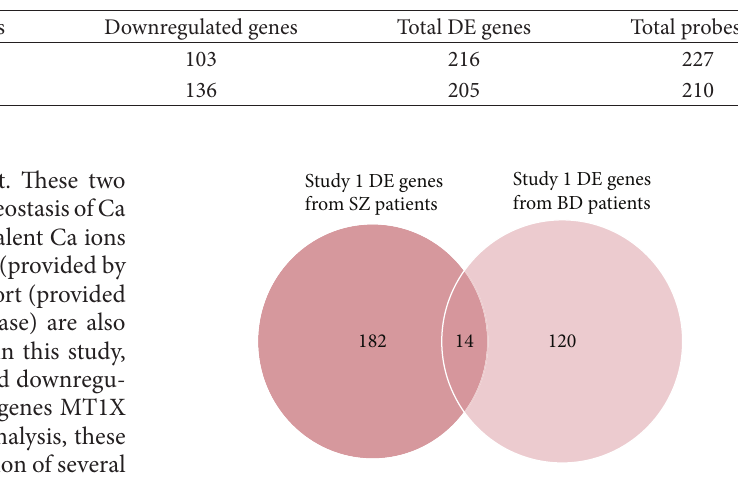
F 2: Venn diagram drawn based on DE genes in SZ and BD patients compared with controls of the �rst study from Brodmann�s Area 10 (cognitive functions, goal formation functions). e com- mon DE genes are represented by the intersection of the two